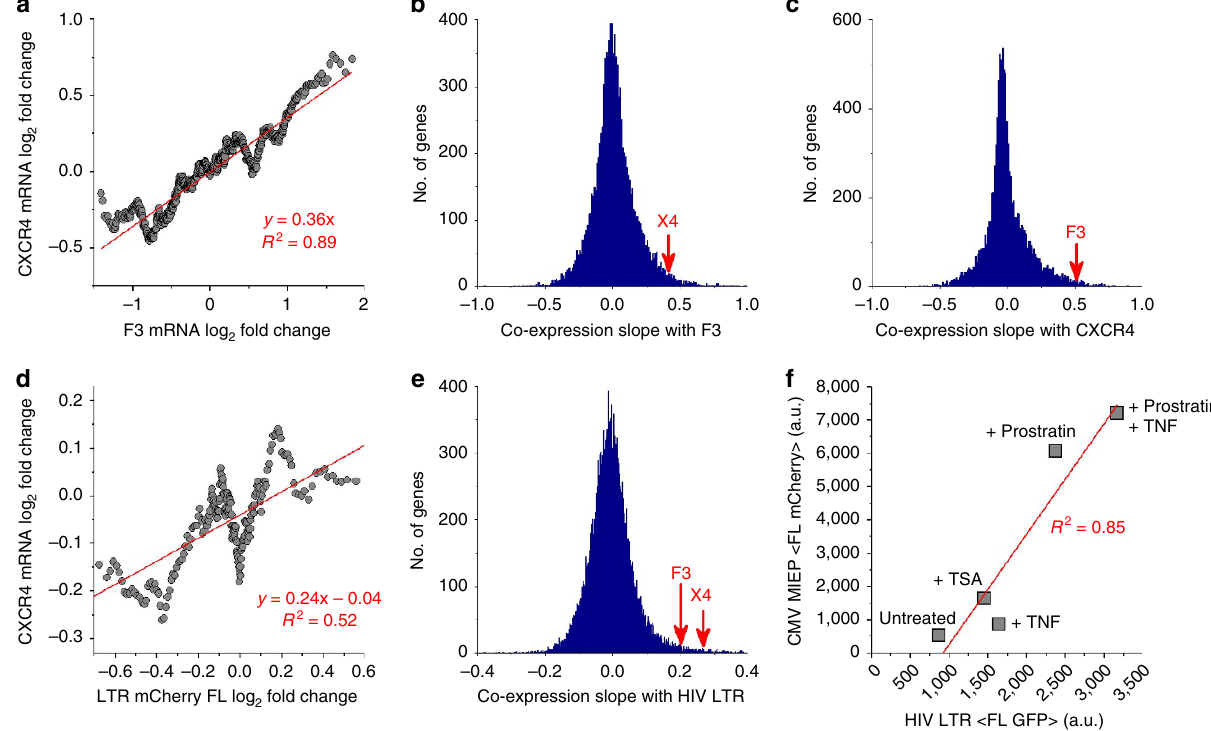
Figure 2 | Genetically coupled promoters are co-expressed across hundreds of drug perturbations. ( a ) Comparison of mRNA fold change for over 800 perturbations of CXCR4 and F3 transcription in HL60 cells after a moving average is applied. ( b , c ) Distribution of correlation slopes (slope of red trend in a ) for over 10k genes compared with either F3 or CXCR4. Both are on the high end of the slope distributions. ( d ) High-throughput flow cytometry of an HIV LTR–mCherry Jurkat cell line 23 treated with 262 drug compounds common to the HL60 microarray data set 22 shows a positive correlation between CXCR4 mRNA levels and mean HIV LTR–mCherry fluorescence. ( e ) F3 and CXCR4 both have high co-expression slopes with the LTR compared with over 10k human genes. ( f ) Mean fluorescence of polyclonal LTR–GFP and MIEP–mCherry Jurkat populations reveals correlation under different drug treatments. All measurements were performed with flow cytometry in duplicate or